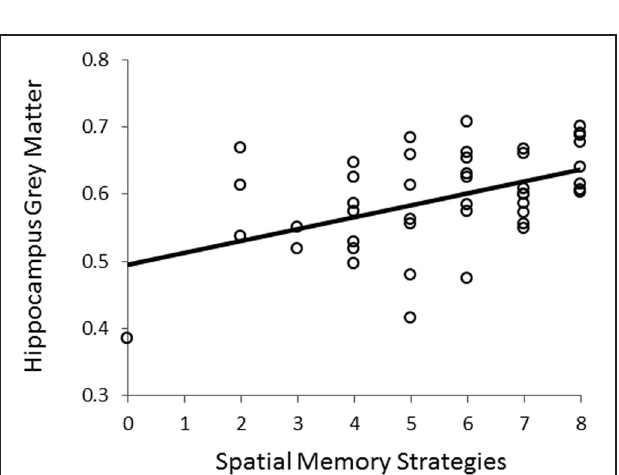
FIGURE 3 | Correlation between scores on the recombined pairs condition (Stage 2) of the CSDLT and gray matter values extracted from the peak voxel (MNI space coordinates x = 26 . 0, y = − 37 . 8, z = − 3 . 2) in the right posterior hippocampus ( r = 0 . 478, p < 0 . 001). This graph shows that a better spatial memory score is associated with increased gray matter in the hippocampus.